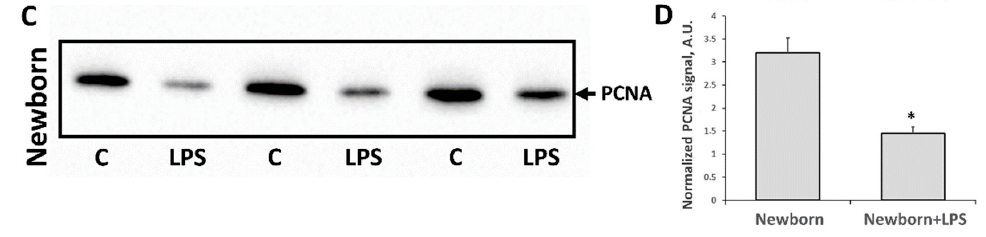
Figure 5. Proliferative activity of kidney cells of newborn and adult rats 24 h after LPS treatment. Immunoblots for proliferating cell nuclear antigen (PCNA) levels in ( A ) adult kidneys and ( C ) neonatal kidneys and their densitometry analysis in ( B ) and ( D ), respectively. Number of animals for western blot densitometry: Adult ( n = 6), Newborn ( n = 6), Adult + LPS ( n = 5), Newborn + LPS ( n = 5). *: p < 0.05.